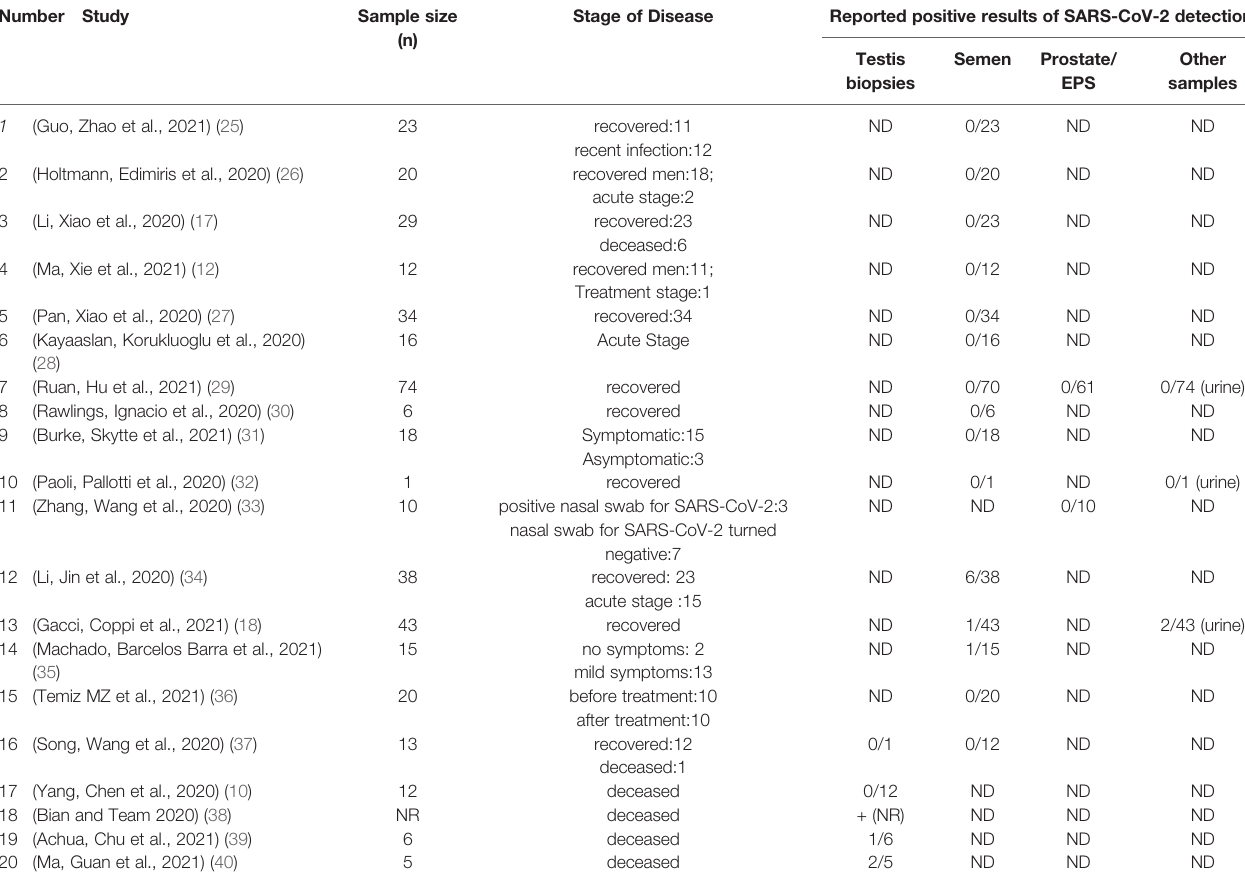
TABLE 1 | Summary of detection of SARS-CoV-2 in the male reproduction system. Number